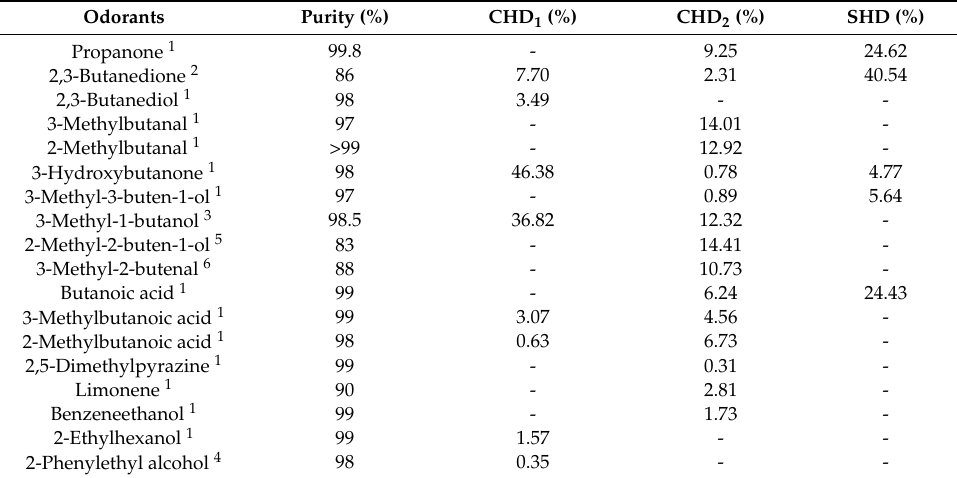
Table 2. Blends of synthetic honeydew odorants prepared according to compositions of crude honeydew collected in this study (CHD 1 ), and in a previous study (CHD 2 ) [32], and of sterilized honeydew (SHD) reported in the previous study [32].